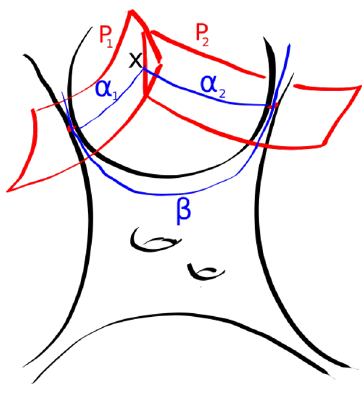
Figure 4 . Planes almost orthogonal to thin tubes cannot